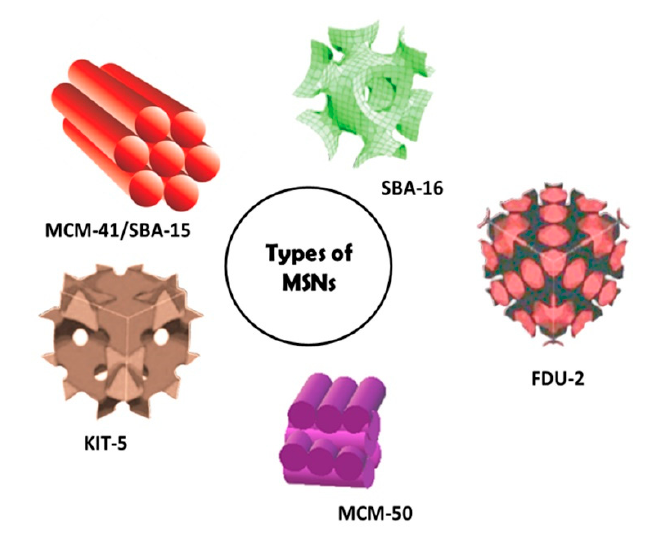
Figure 4. Representation of different types of mesoporous silica nanoparticles (MSNs). IUPAC defines mesoporous materials as characterized by a pore size in the range of 2–50 nm and an ordered arrangement of pores giving an ordered structure to it (Reprinted from ref. [41]. Copyright 2018 by the authors. Licensee MDPI, Basel,